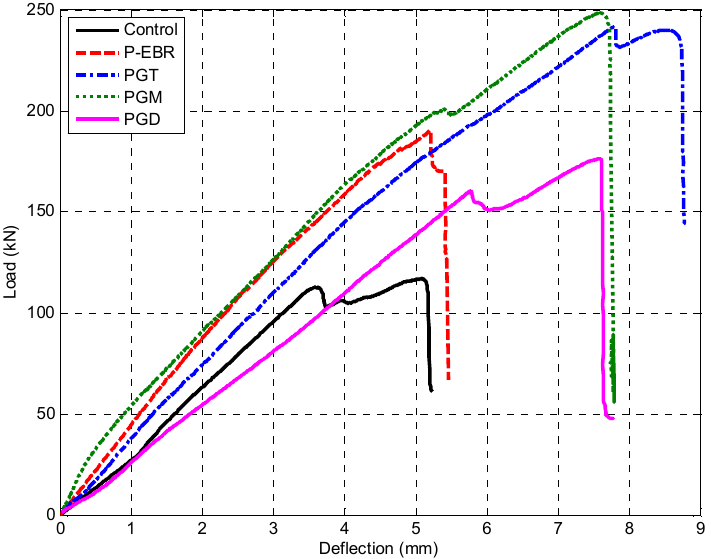
Figure 9. Load deflection curves for PGT, PGM, and PGD beam.